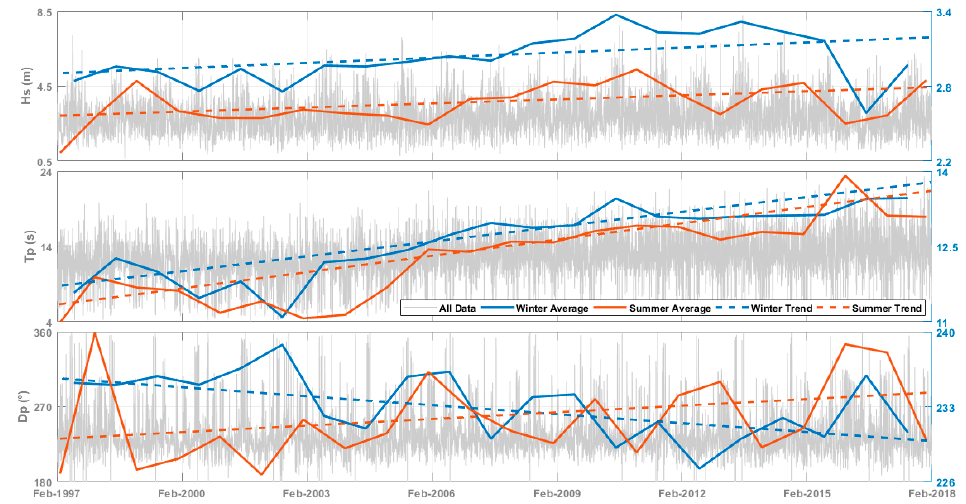
Figure 7. NOAA buoy spectral wave data time series (37° S 74° W) between February 1997 and February 2018. Table 4. Tidal constituent derived from Coronel’s tidal gauge. Tide (Const.)